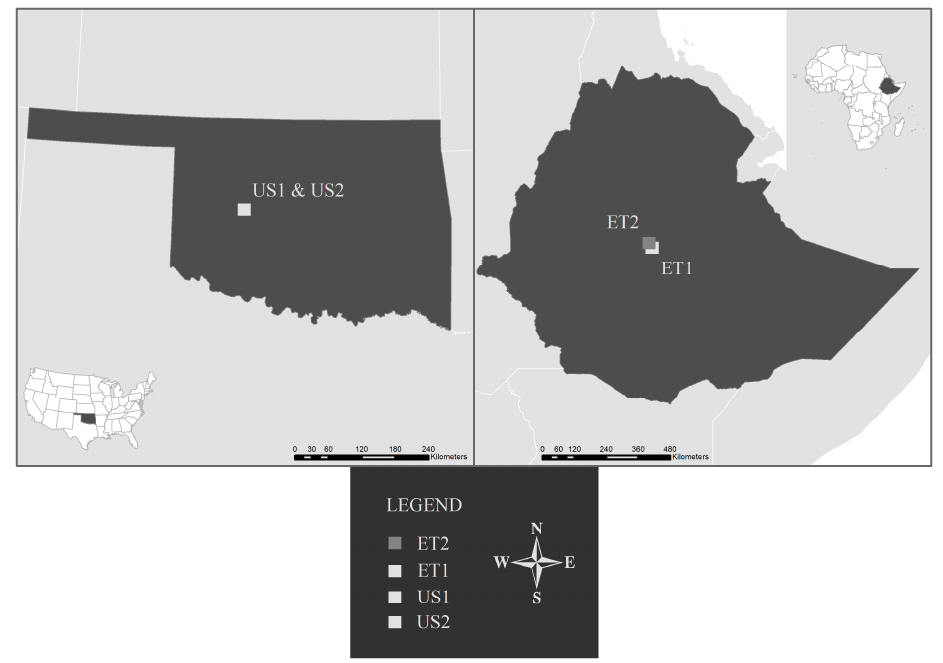
Figure 1. Locations of the four study sites .